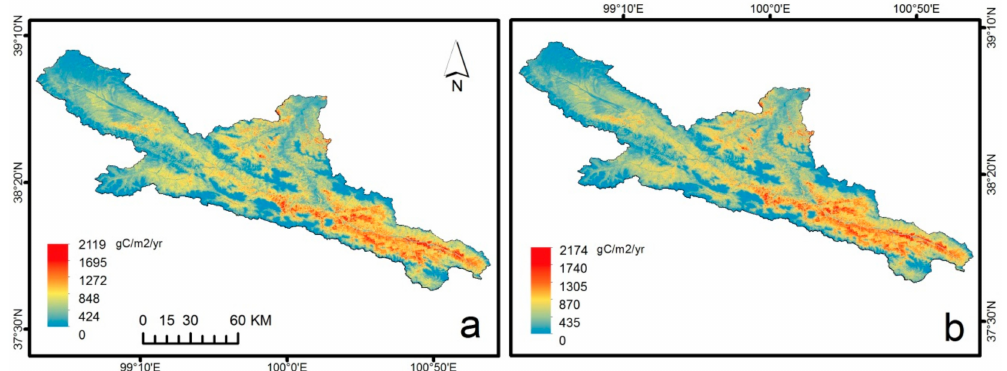
Figure 10. Simulated spatial patterns of annual total GPP for 2013 ( a ) and 2014 ( b ) in the Upper Heihe